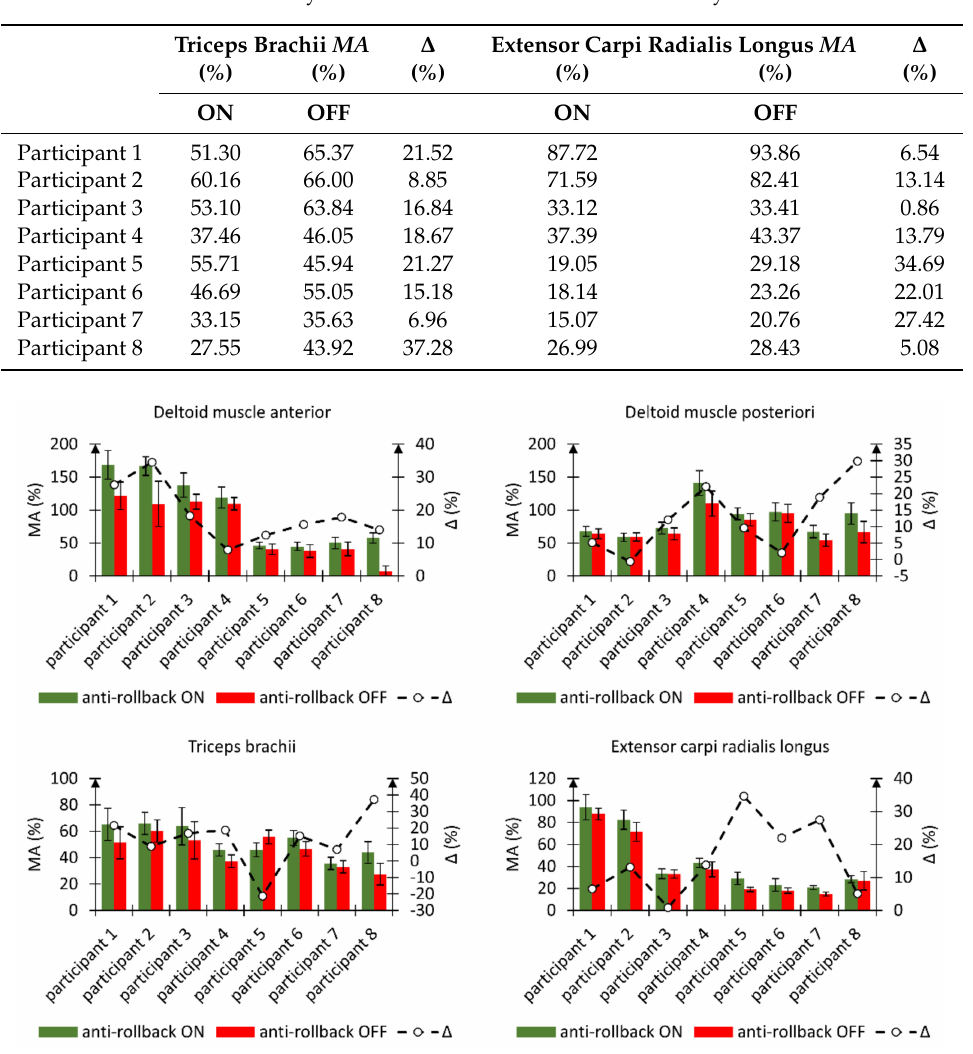
Figure 11. The diagrams of the average muscle activity for respective participants with the activated anti-rollback system (anti-rollback ON) and with the deactivated anti-rollback system (anti-rollback system OFF). Where: ∆ —a percentage di ff erence between the muscle activity measured with the activated anti-rollback-system and with the deactivated